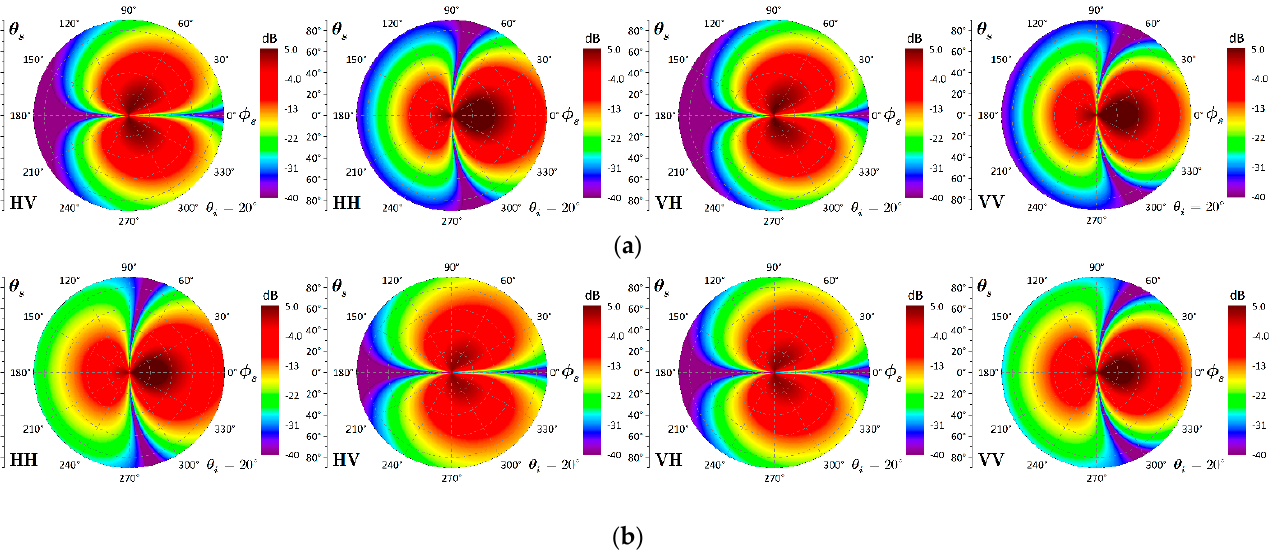
Figure 8. Bistatic scattering from the Gaussian and exponential HPDs with Gaussian PSD: kl = 8, k σ = 1.0, ε r = 15 − j 1.5, θ i = 20. ( a ) Gaussian HPD and Gaussian PSD (Gau HPD and Gau PSD), ( b ) exponential HPD and Gaussian PSD (Exp HPD and Gau PSD).